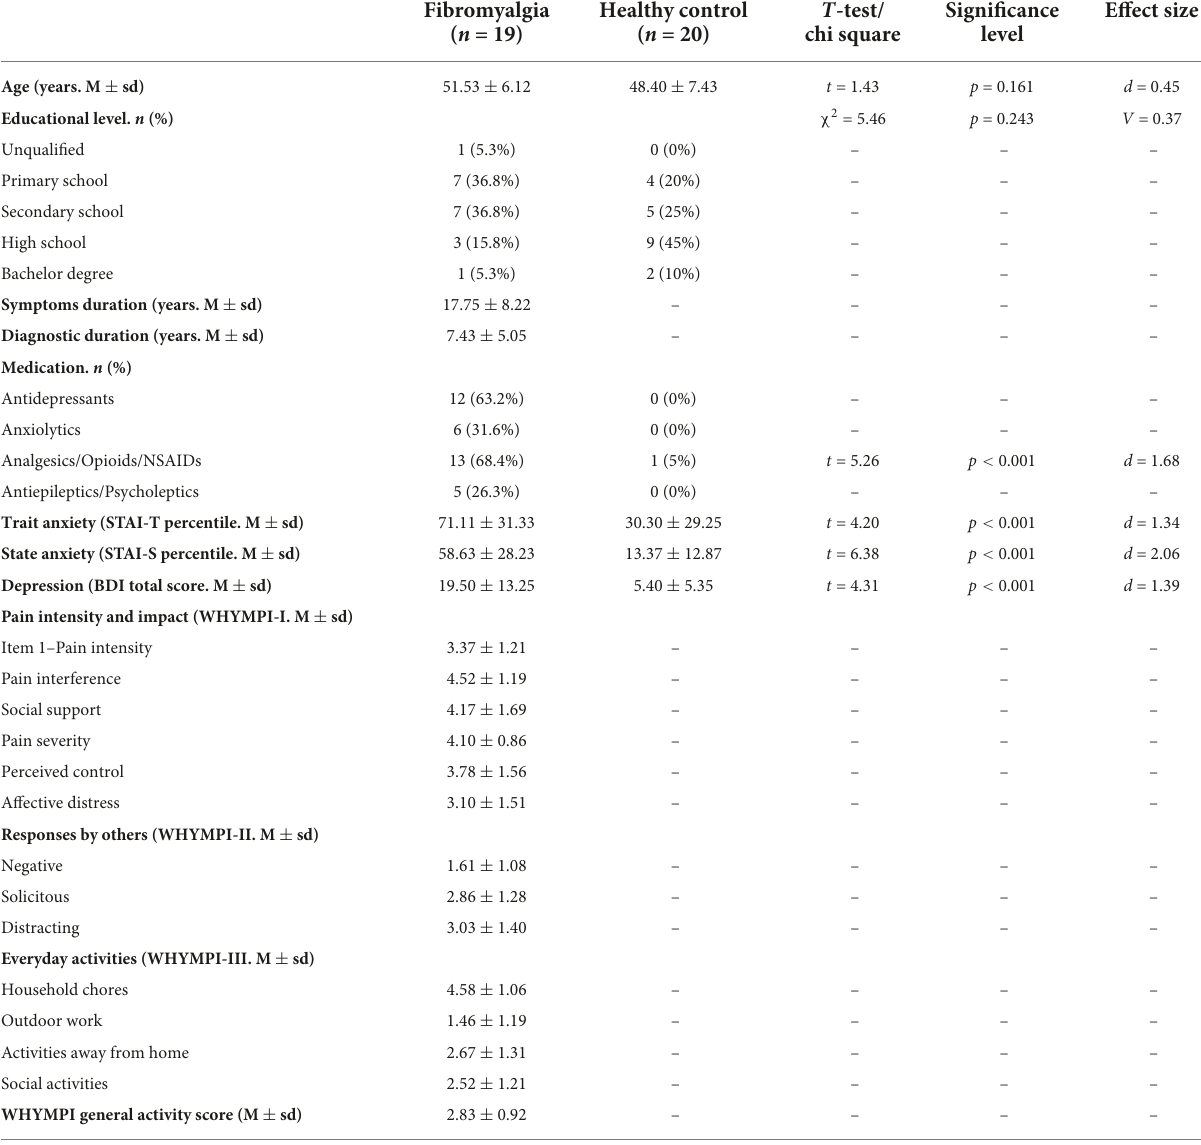
TABLE 1 Sociodemographic and clinical